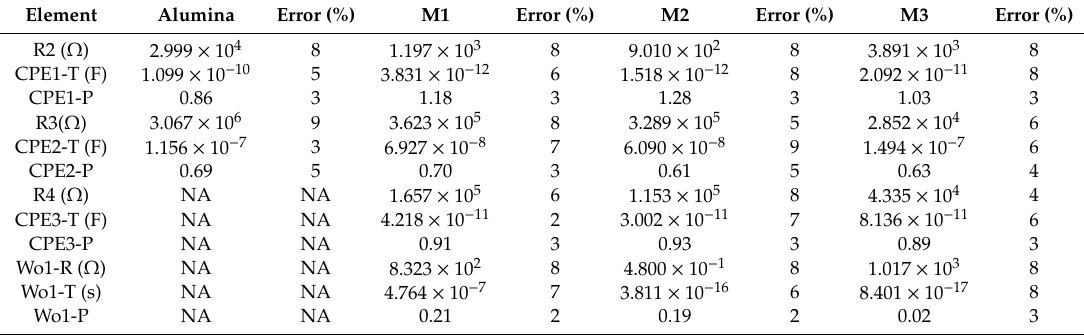
Table 2. Circuital element values that have physical meaning and the adjust experimental results. Element